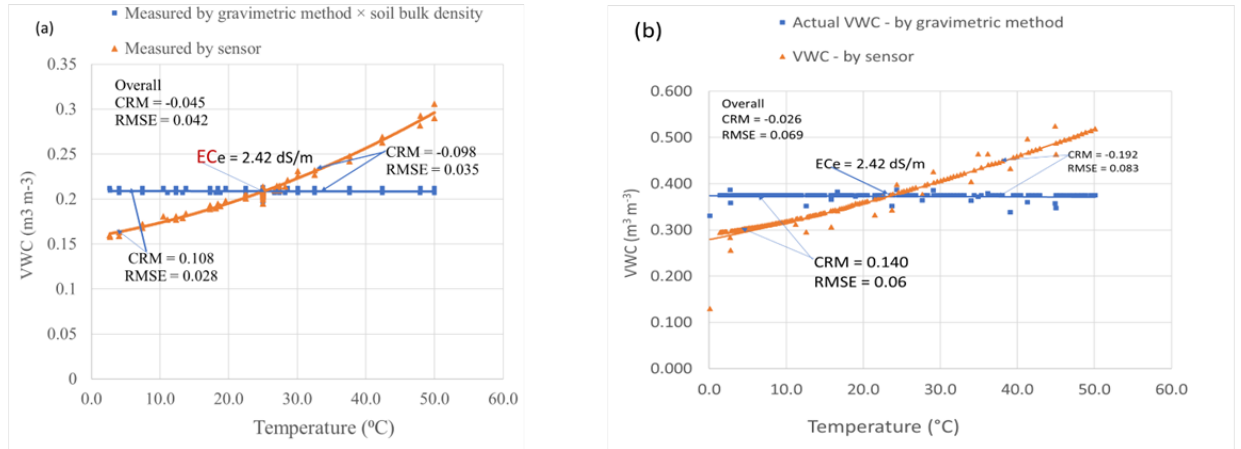
Figure 5. Influence of soil temperature on sensor measurements at ( a ) field capacity and ( b ) saturated